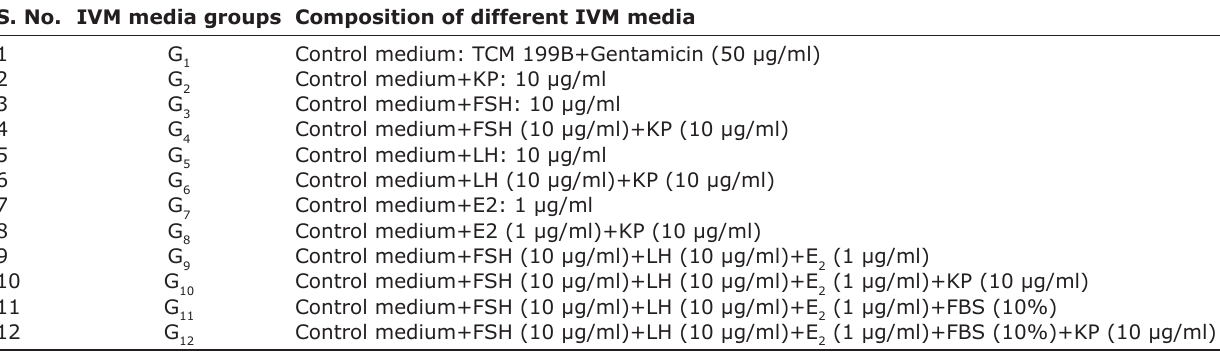
Table-1: Components of IVM media used in the experiment